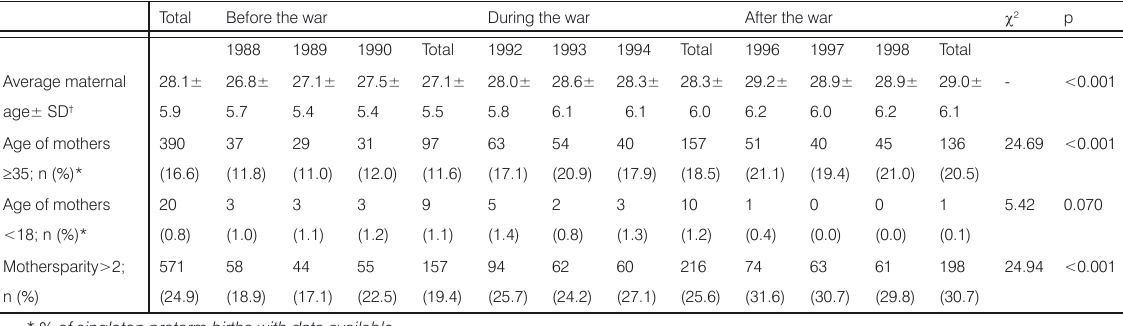
* % of singleton preterm births with data available † ANOVA, F=19.79 Table 4. Average birth weight (g) according to gestational age in preterm singleton births during the three-year periods before (1988-1990), during (1992-1994), and after (1996-1998) the war in Croatia and Bosnia and Herzegovina in Split University Hospital.